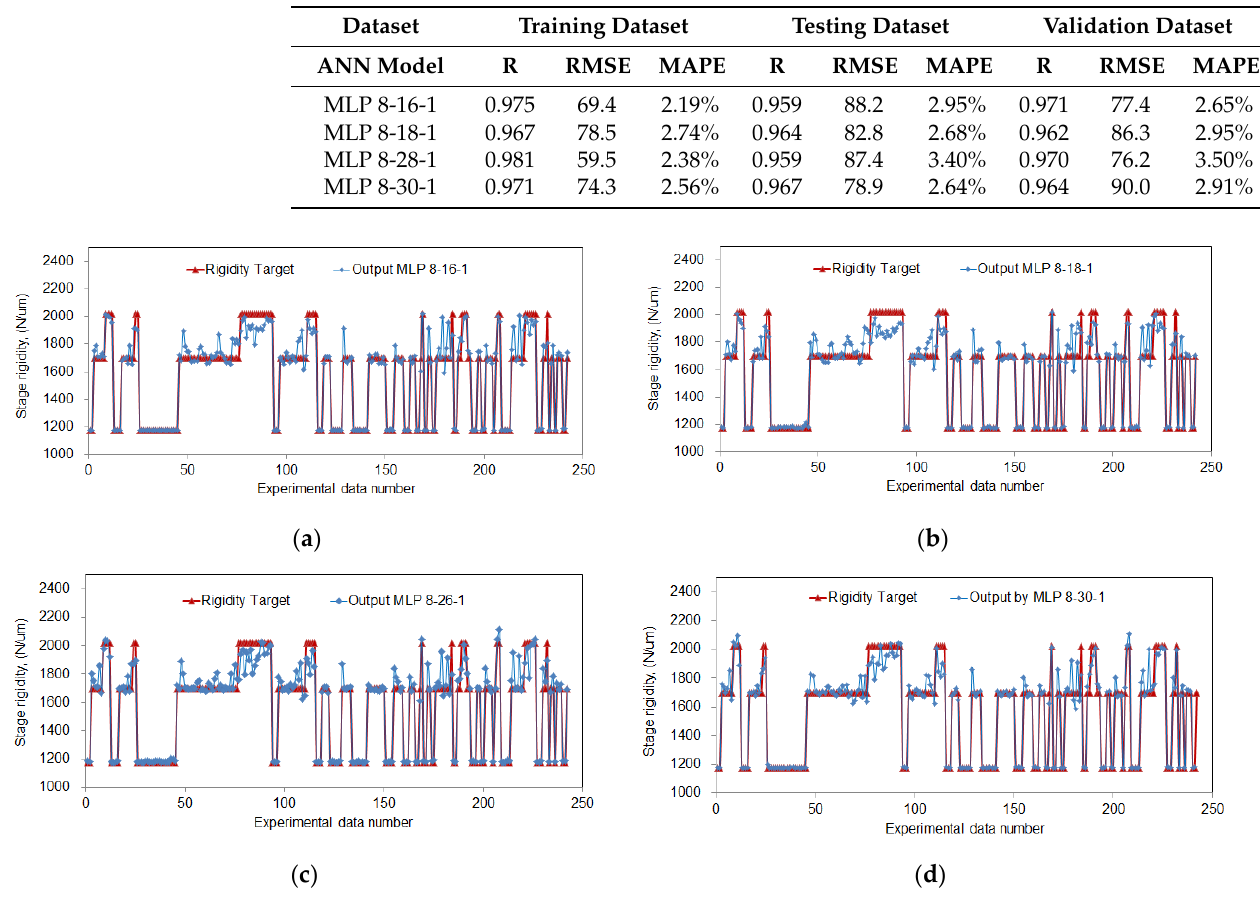
Figure 15. Comparisons of the stage rigidity between rated values and ANN predictions: ( a ) MLP 8-16-1; ( b ) MLP 8-18-1; ( c ) MLP 8-26-1; ( d ) MLP 8-30-1. Table 7. Statistical values of neural network models.